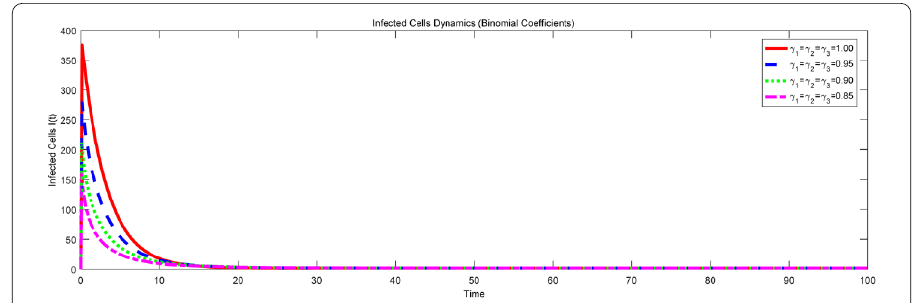
Figure 18 Dynamics of I ( t ) with γ i = 1 (solid red line), γ i = 0.95 (dashed blue line), γ i = 0.9 (dotted green line) and γ i = 0.85 (dotted dashed magenta line), i = 1,2,3.